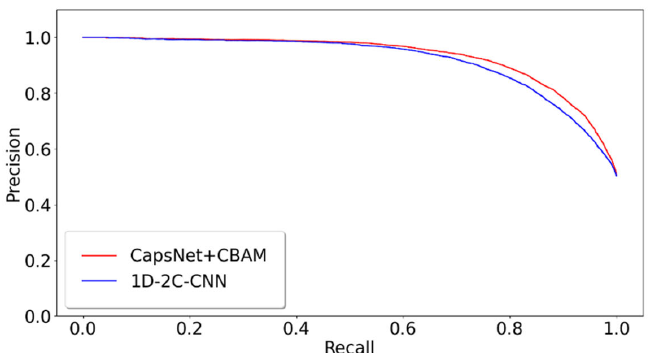
Figure 4. PR comparison of peptide detectability prediction between CapsNet + CBAM and 1D ‐ 2C ‐ CNN.